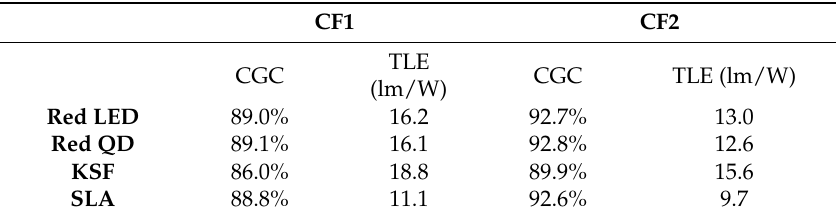
Table 2. Optimized values of wide color-gamut IPS LCDs using different red